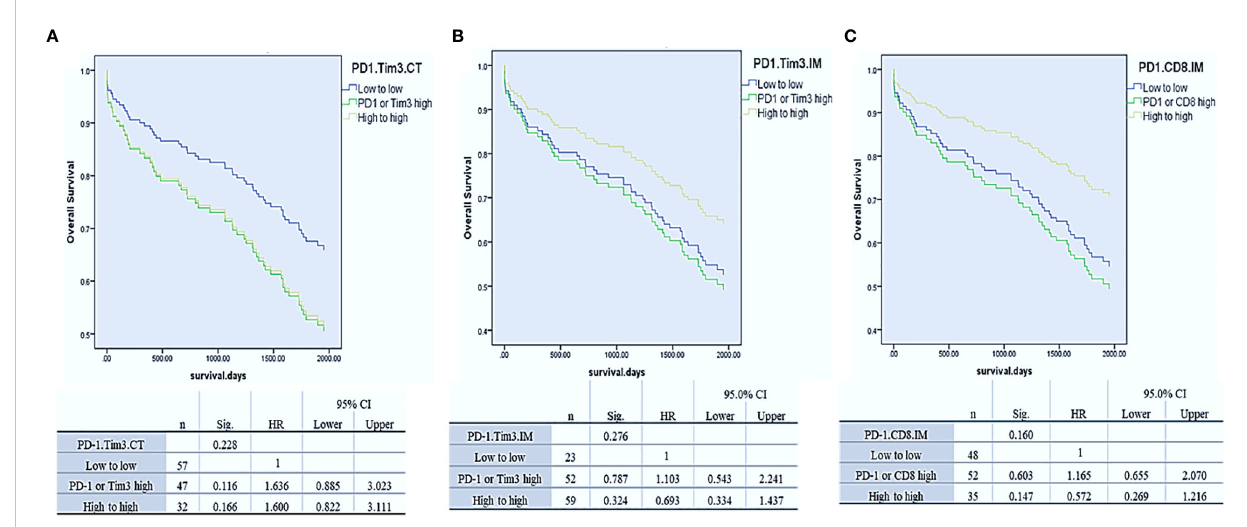
FIGURE 3 Cox-regression survival analysis of PD-1/Tim3 co-expression in the center of the tumor (CT, A ) and invasive margin of the tumor (CT, B ) and analysis of PD-1/CD8 co-expression in the IM (C)